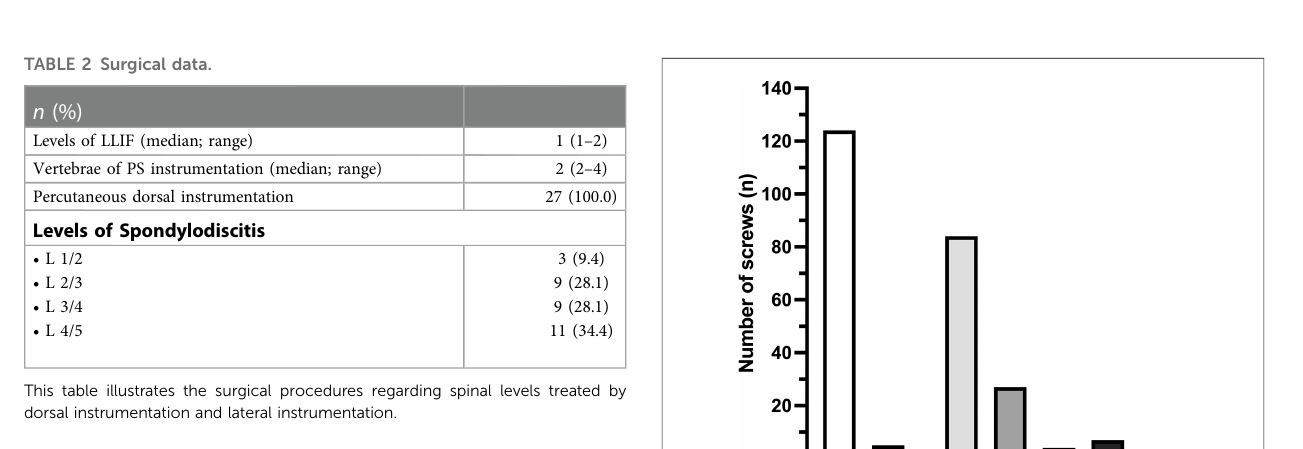
FIGURE 3 Duration of surgery. The duration of surgery of all 27 patients with an average duration of 147 min (ticked line), a minimum duration of 69 min (patient 5) and a maximum duration of 233 min (patient 14) is illustrated in this fi gure.